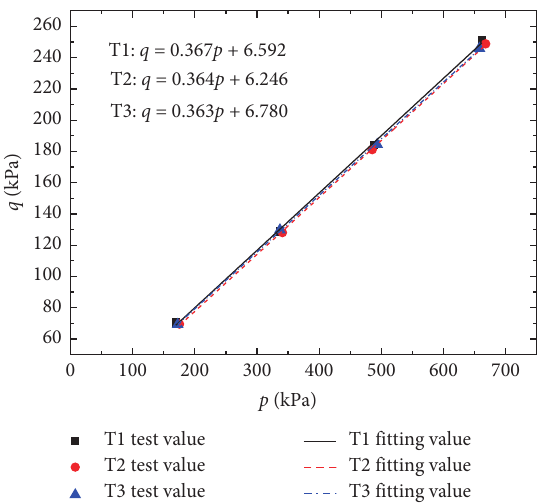
Figure 3: Axial load and void ratio curves of one-dimensional consolidation tests ( p ∼ e ).